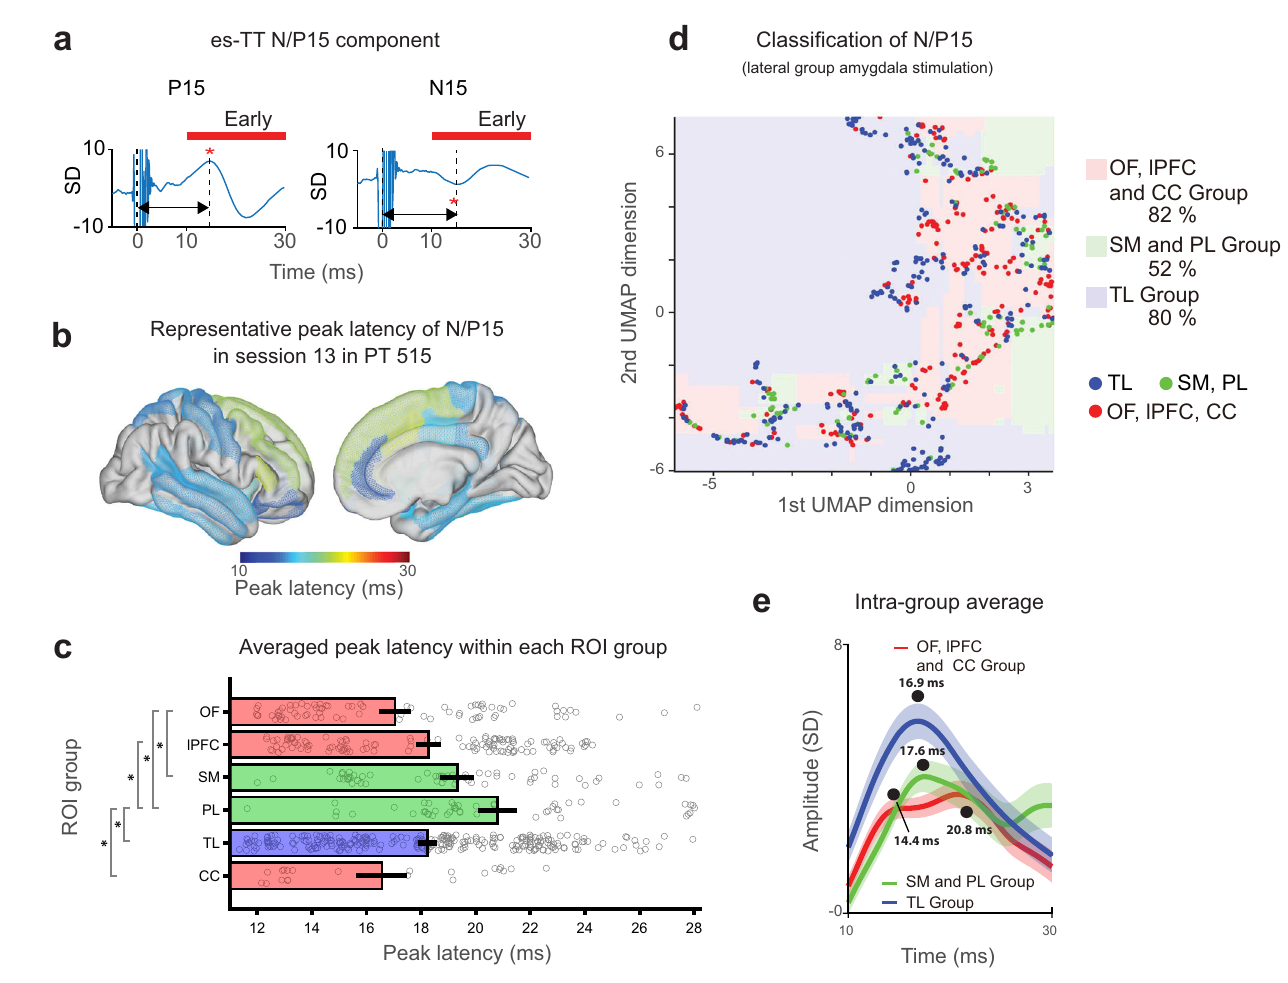
Fig. 4 | es-TT latency analysis for early time window (N/P15) (lateral group amygdala stimulation). a De fi nition and measurement for the early EPs. Red asterisksindicatepeakofN/P15componentintheEPs.Redhorizontalbarsindicate early time window. b Representative N/P15latencydistribution color-codedwithin ROIs on MNI brain in one patient (lateral amygdala stimulation). c Latency dis- tributionwithin6anatomicalgroups(see “ Methods ” ).MeanandSE(barsanderror bars) are shown together with each data points represented by gray circles. One- way ANOVA showed signi fi cant difference among groups, F(5,587)=6.93, P =2.65×10 − 6 .OF:orbitofrontalcortexgroup,lPFC:lateralprefrontalcortexgroup, SM: sensorimotor cortex group, PL: Parietal cortex group, TL: Lateral temporal cortex group and CC: Cingulate cortex group (anterior and dorsal posterior cin- gulate gyrus). Signi fi cant post hoc comparisons were indicated by asterisks on the verticalgray bars(Tukey ’ s test, see main texfor exact P -values).Numberof EPs are